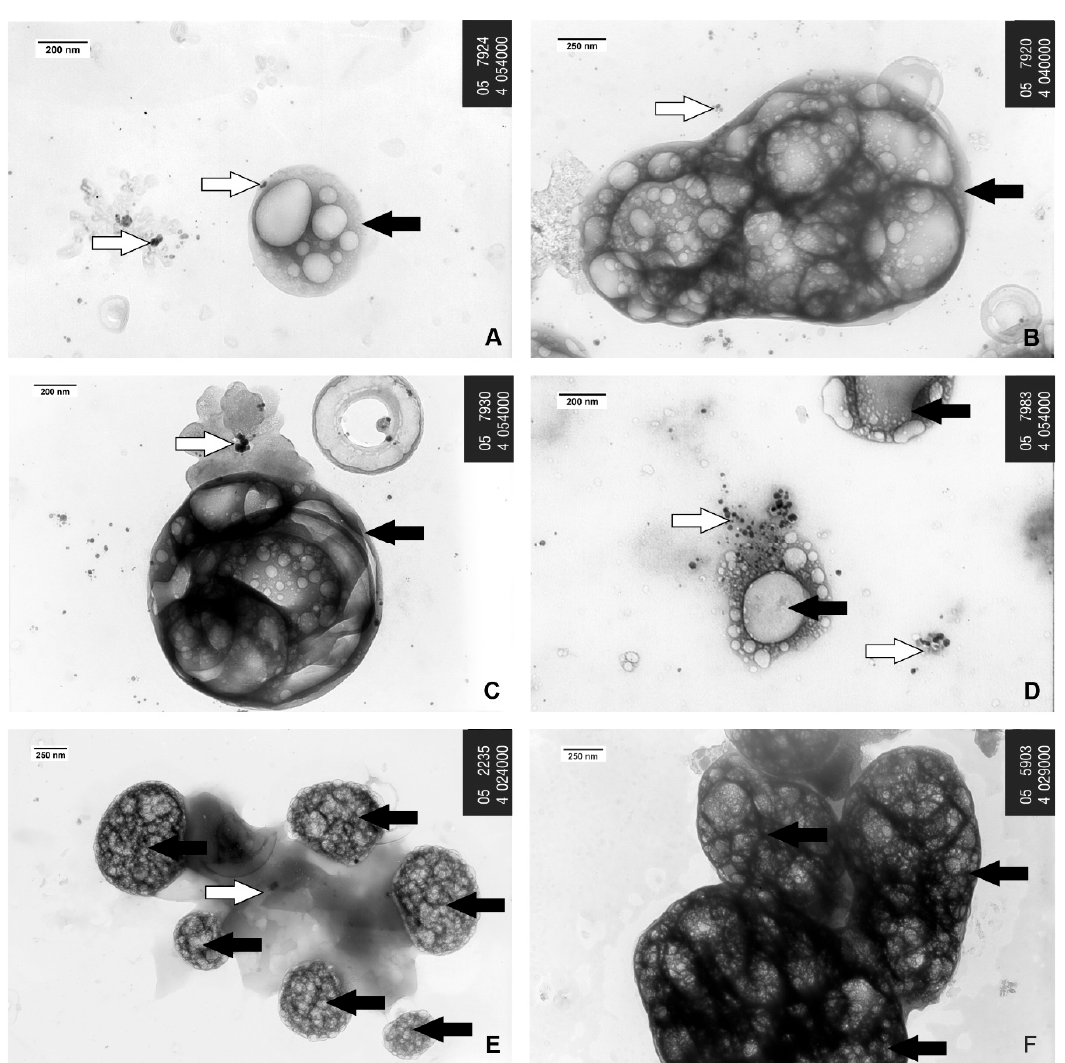
Figure 6. TEM images of the interaction of AgNPs nanocomposites with E. coli after ( a–c ) 1 h, ( d ) 2 h and ( e ) 24 h incubation, ( f ) control. Black arrows—bacteria, white arrows—nanocomposite.